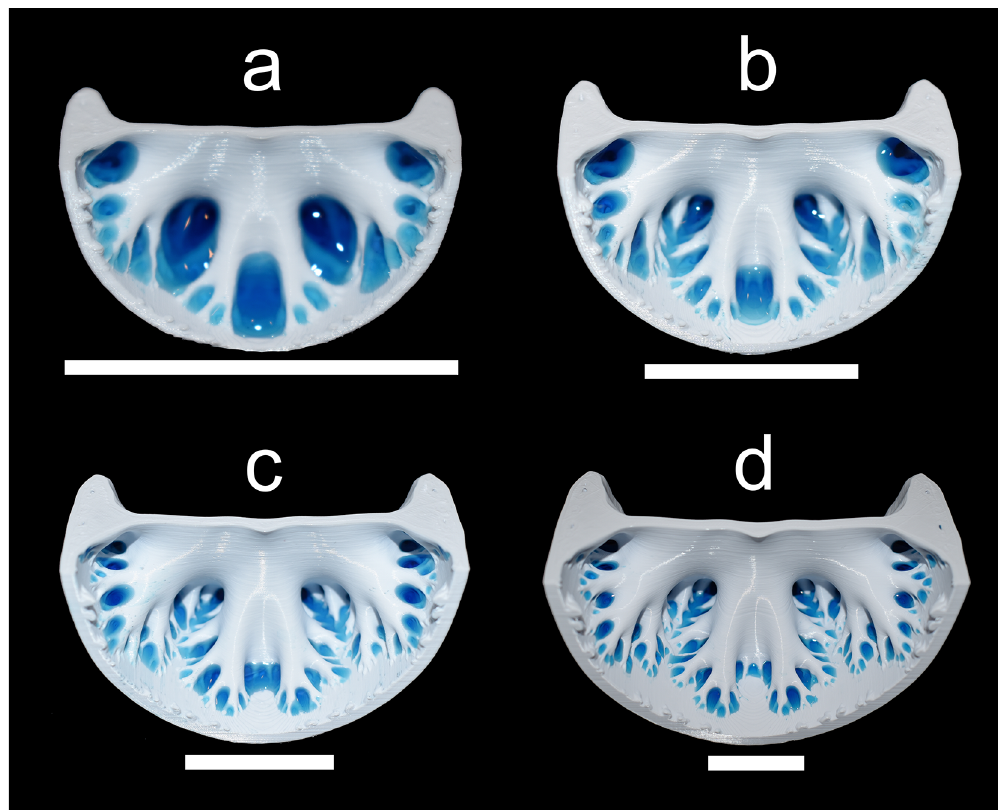
Figure 6. Demonstration of liquid retention along the septal margins of the Menuites oralensis chamber models (adapical view). These trimmed models correspond to chambers with whorl heights of 25, 40, 60 and 90 mm ( a – d , respectively). All scale bars = 3 cm. Water is dyed blue for